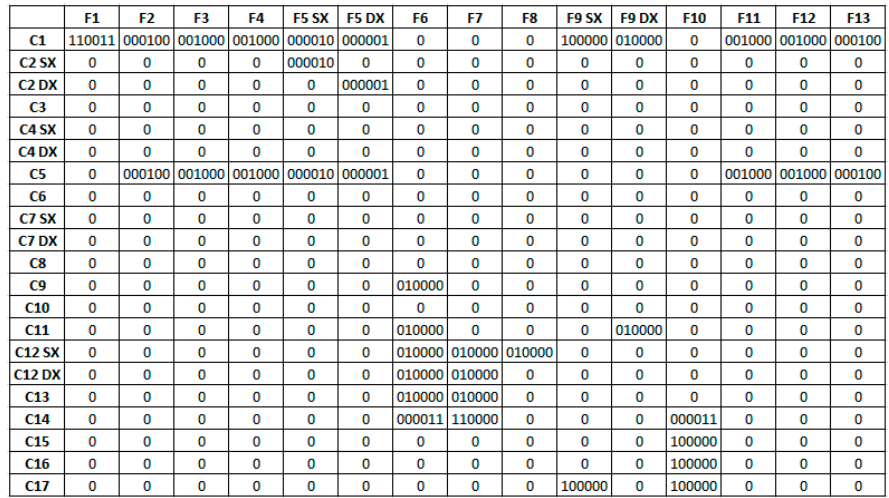
Figure 15. CFM (components fasteners matrix).